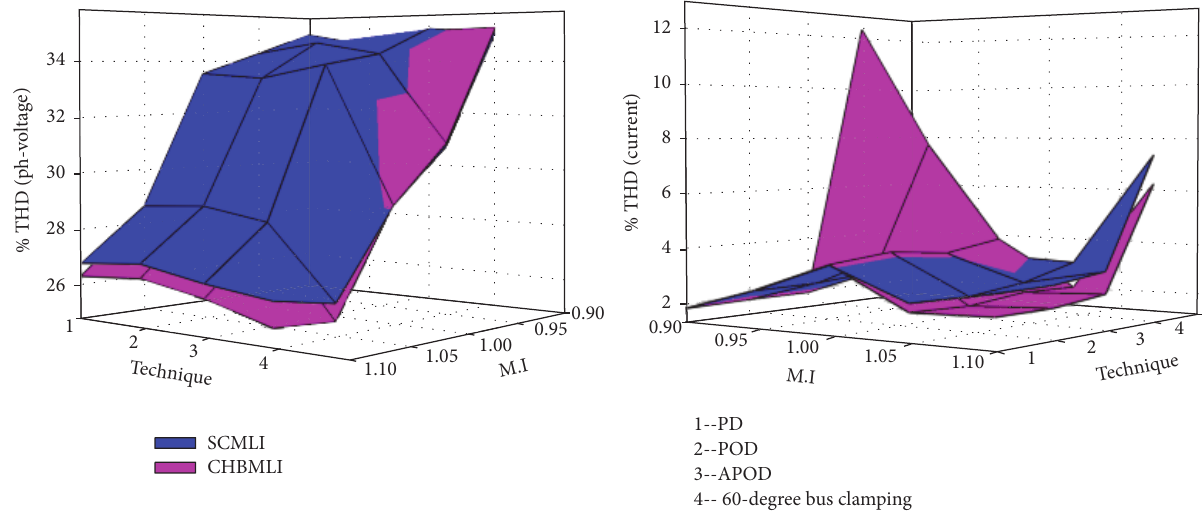
Figure 16: Comparison of harmonic distortion in SCMLI and CHBMLI at various modulation